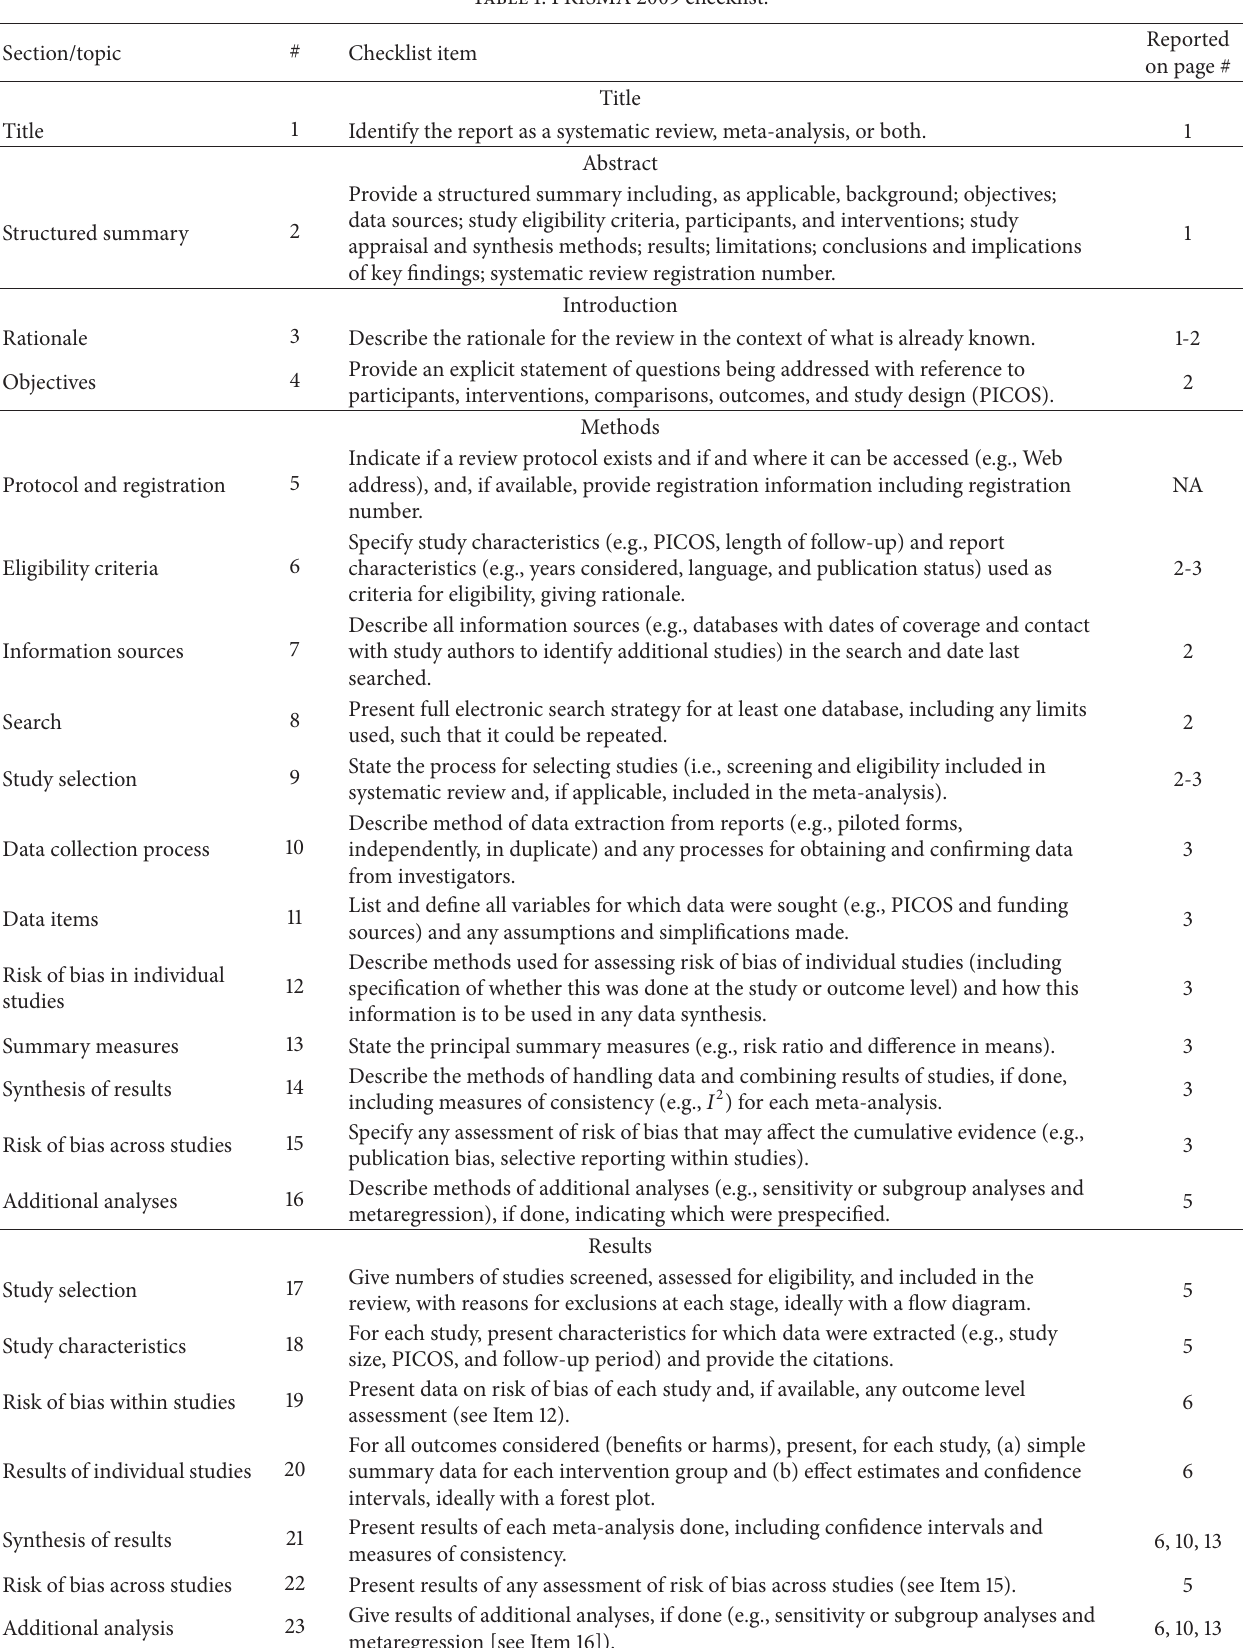
Table 1: PRISMA 2009